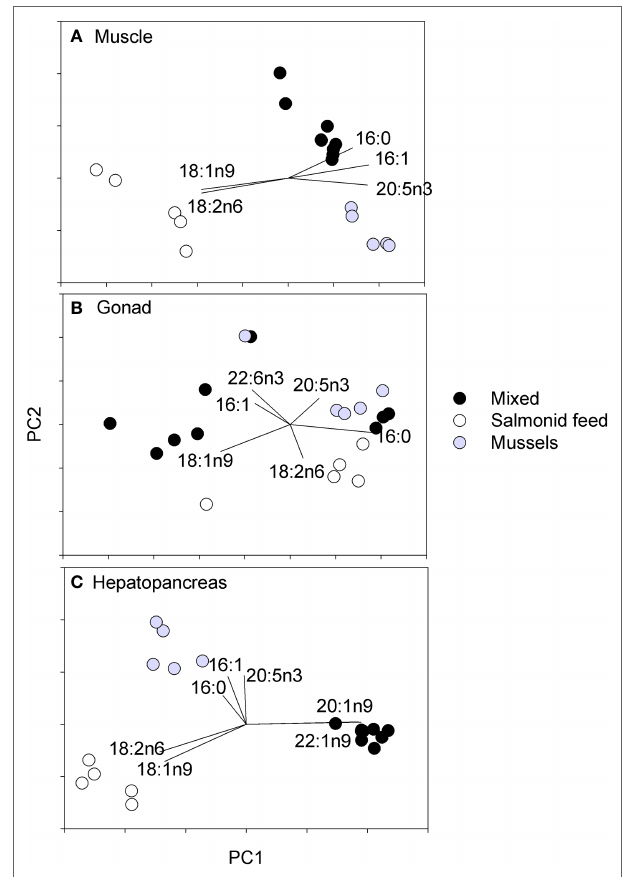
FIGURE 8 | Principle component (PCA) analysis of the lipidic profiles in (A) muscle, (B) gonad, and (C) hepatopancreas of rock crabs, Cancer irroratus fed different experimental diets. Dots show means for each experimental tank (n = 5-9 for the different diets) and lines show loading of the fatty acids that contributed the most to diet differences (SIMPER analysis) within each tissue. The total number of individuals included in the analyses was 23, 11, and 13 for the mixed, salmonid feed and mussel diets,